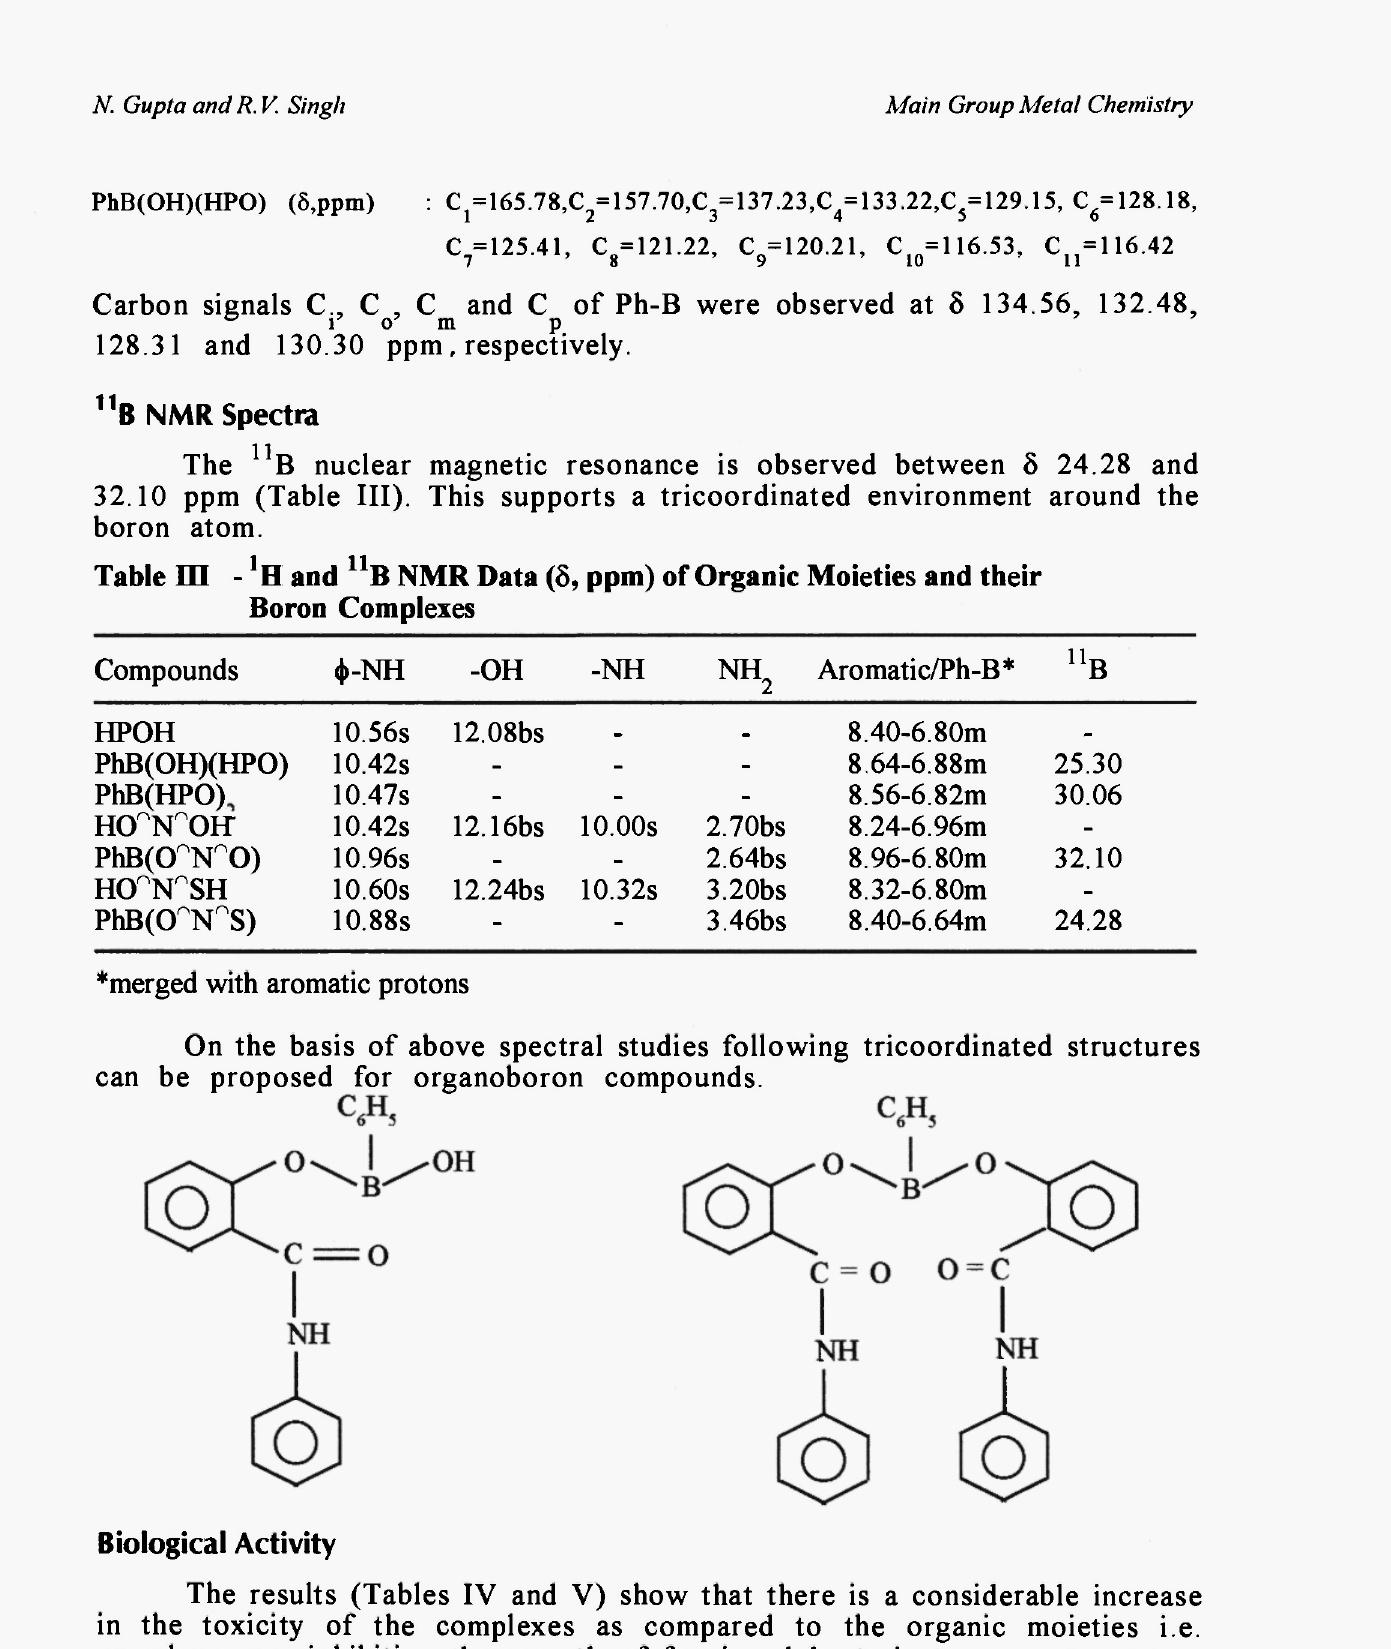
Table m - 'h and n B NMR Data (δ, ppm) of Organic Moieties and their Boron